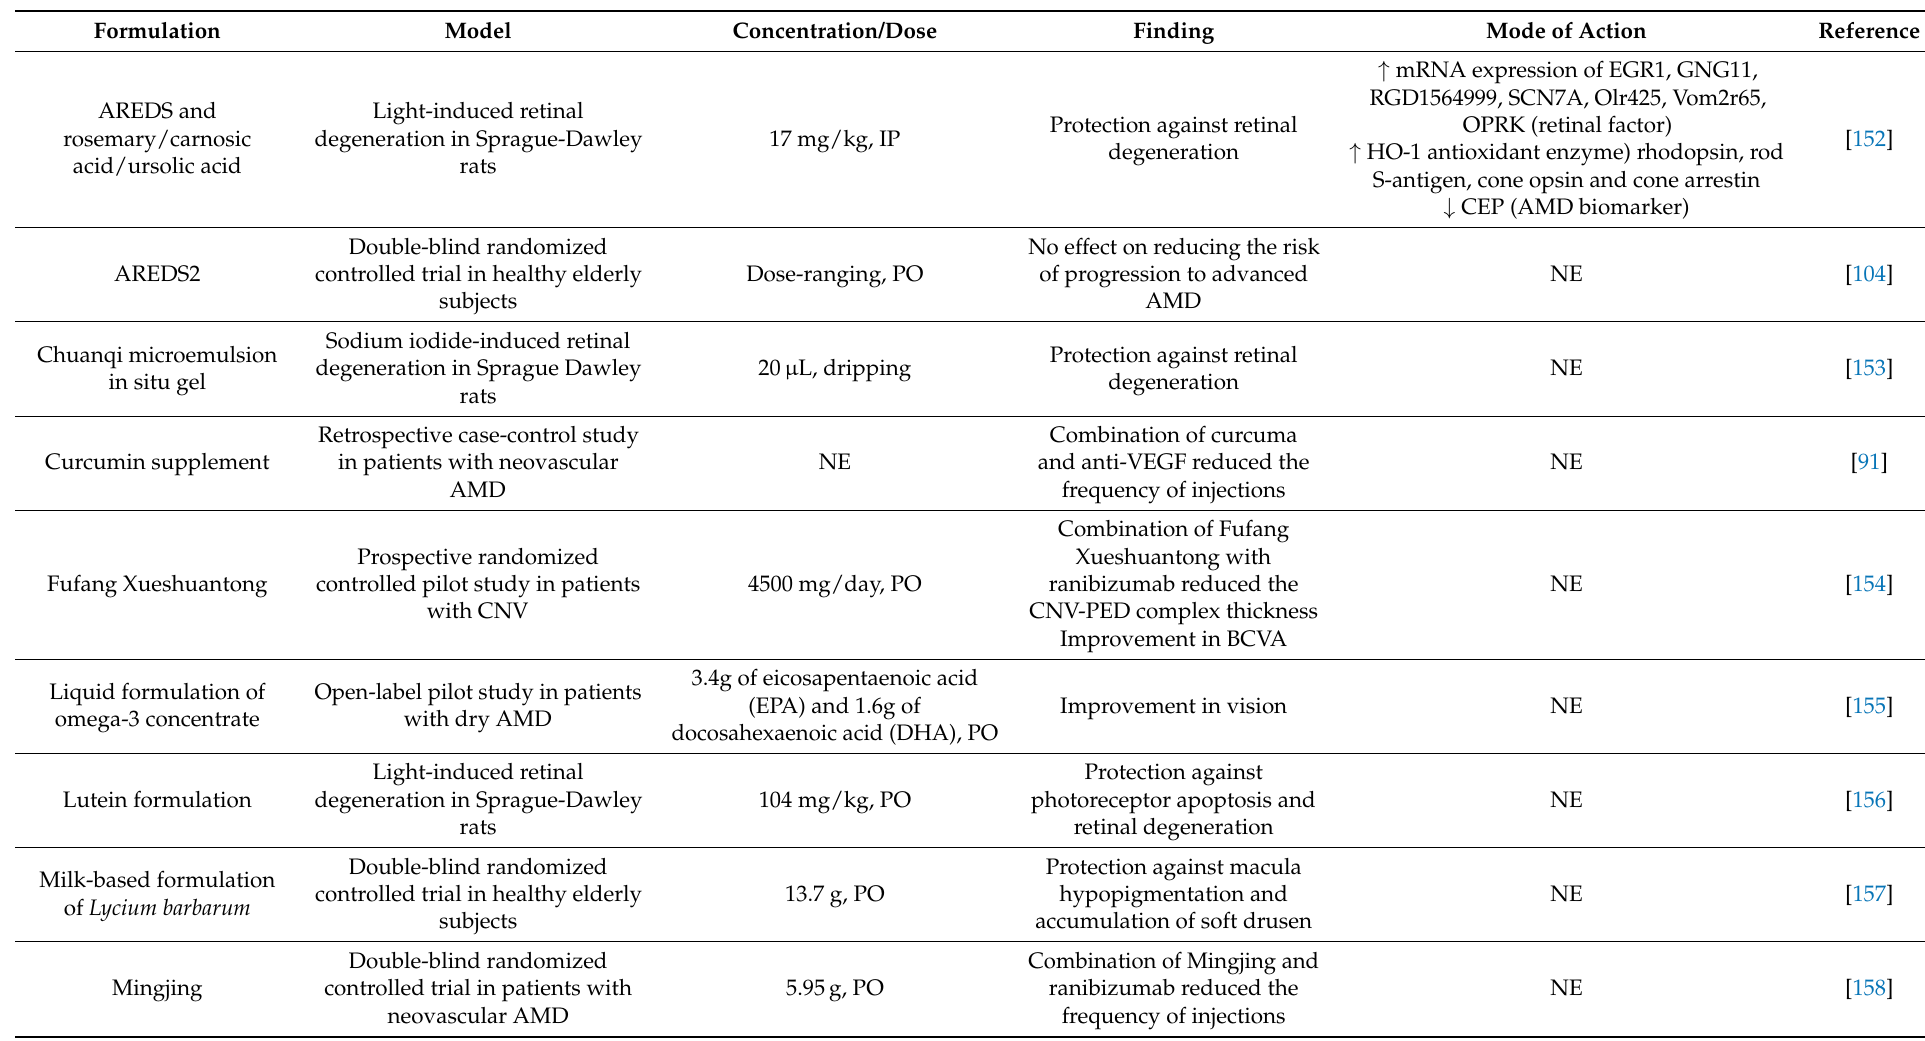
Table 5. Formulations in the alleviation of